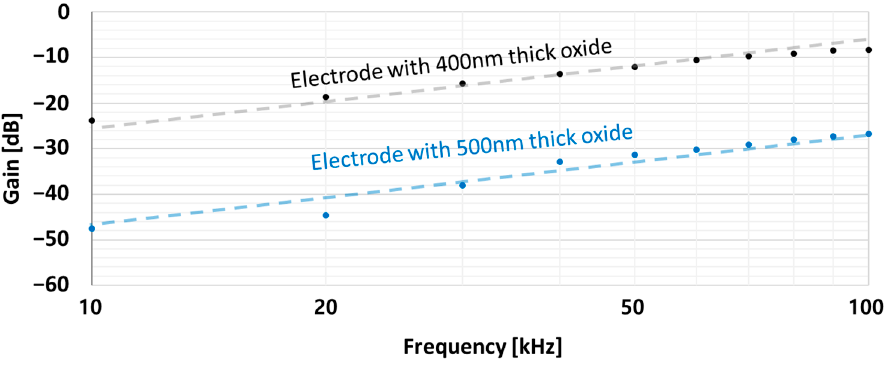
Figure 9. Frequency responses of the ToGoFET probe from 10 kHz to 100 kHz at the center of the buried electrode.